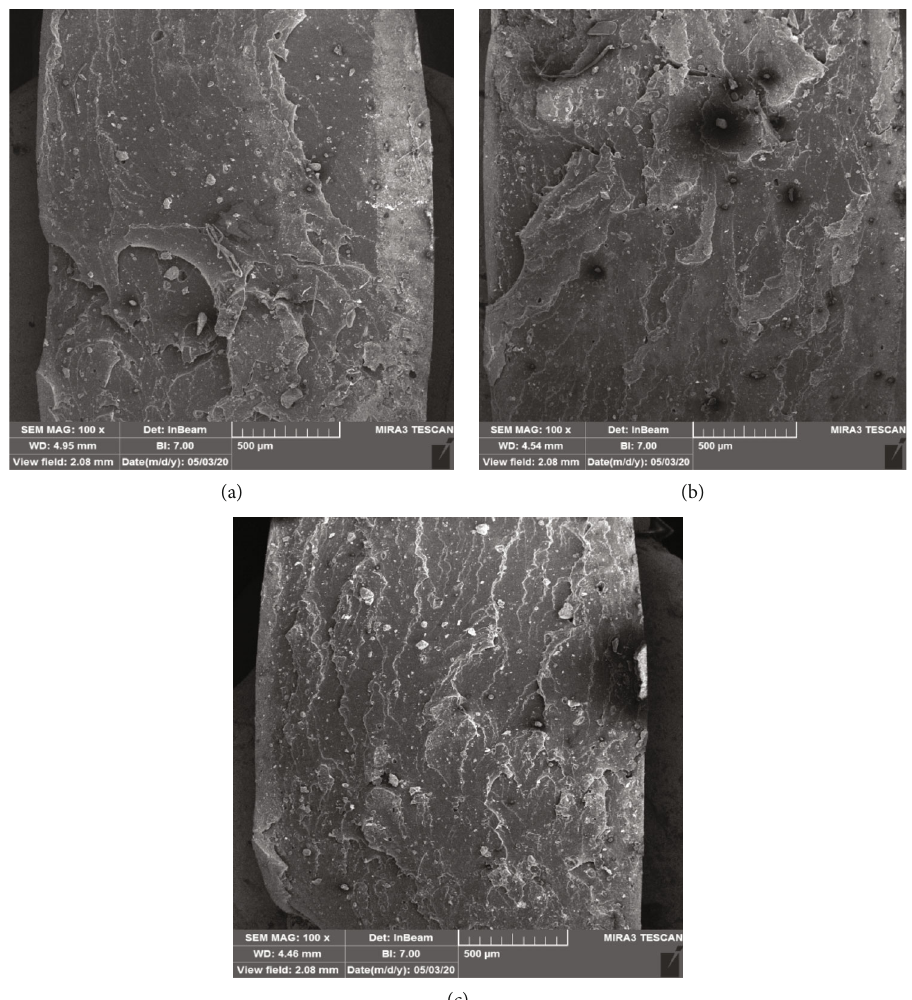
Figure 14: SEM image: (a) 50% strain amplitude for S40N60C5 sample, (b) 60% strain amplitude for S40N60C5 sample, and (c) 70% strain amplitude for S40N60C5 sample.